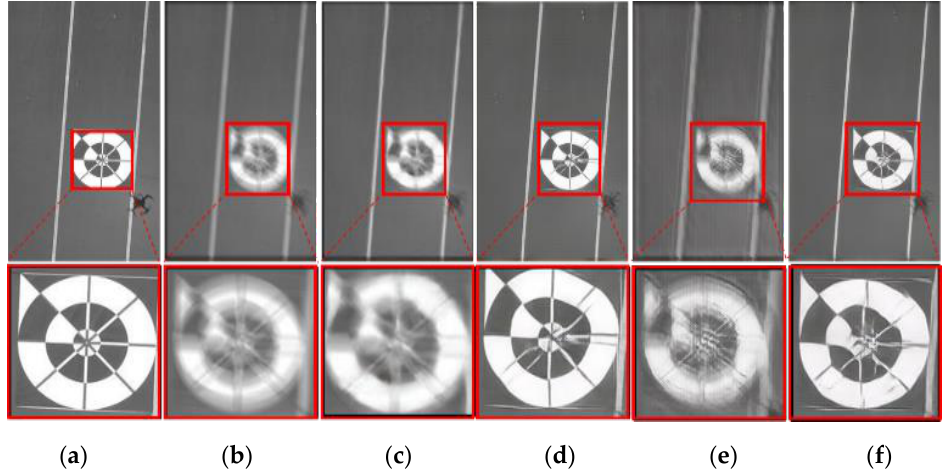
Figure 11. Examples of motion deblurring on SMBD-DB1. ( a ) Ground truth original image, ( b ) motion-blurred image, motion deblurring by ( c ) DeepDeblur, ( d ) DeblurGAN, ( e ) DeblurGAN (MobileNet), and ( f ) SlimDeblurGAN (ours).